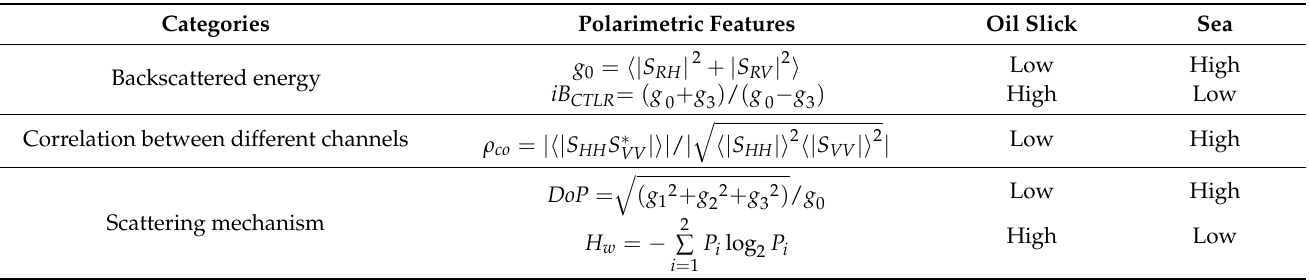
Table 2. Defining formulas for the five polarimetric characteristics and their expected behavior for oil slicks and seawater.